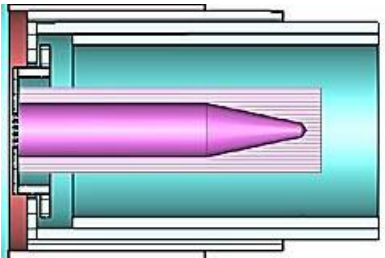
Fig. 1. Design of multibeam depressed collector with dissected collector polepiece